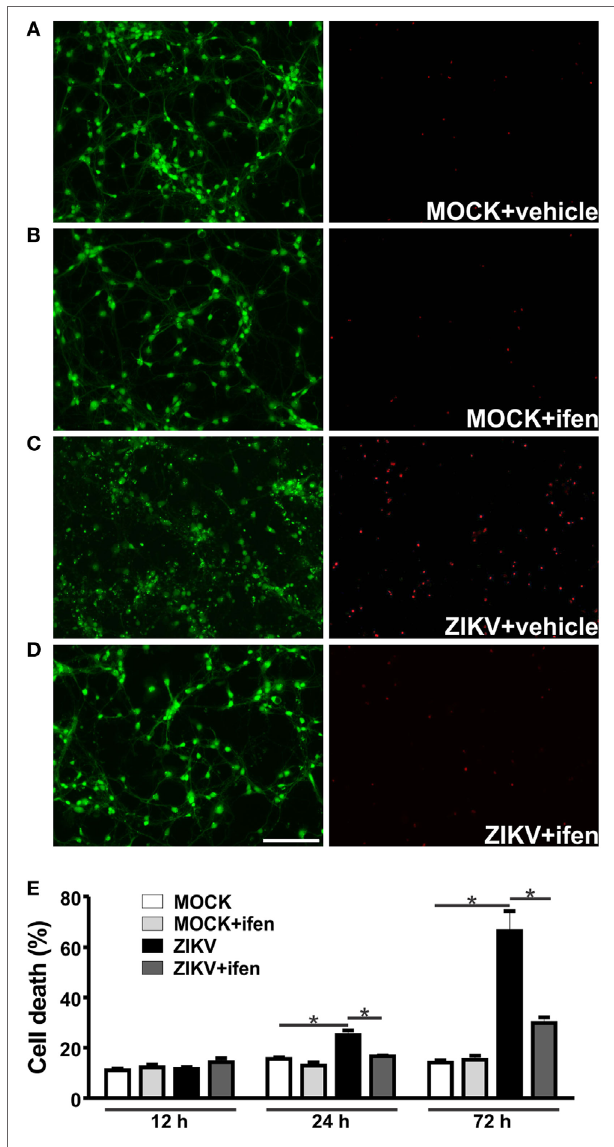
FigUre 2 | Ifenprodil rescues Zika virus (ZIKV)-induced neurotoxicity. Shown are representative images for primary cultured corticostriatal neurons labeled with calcein AM (green, live cells) and ethidium homodimer-1 (red, dead cells) that were MOCK-infected and either untreated (vehicle) (a) or treated with 0.01 µM ifenprodil (B) or that were ZIKV-infected and either untreated (c) or treated with 0.01 µM ifenprodil (D) . Size bar corresponds to 50 µm in all images. (e) Graph shows percentage of neuronal cell death in primary cultured corticostriatal neurons that were either untreated or treated with ifenprodil 0.01 µM for 12, 24, or 72 h following MOCK or ZIKV infection. Data represent the means ± SEM, n = 4. * indicates significant differences ( p < 0.05).